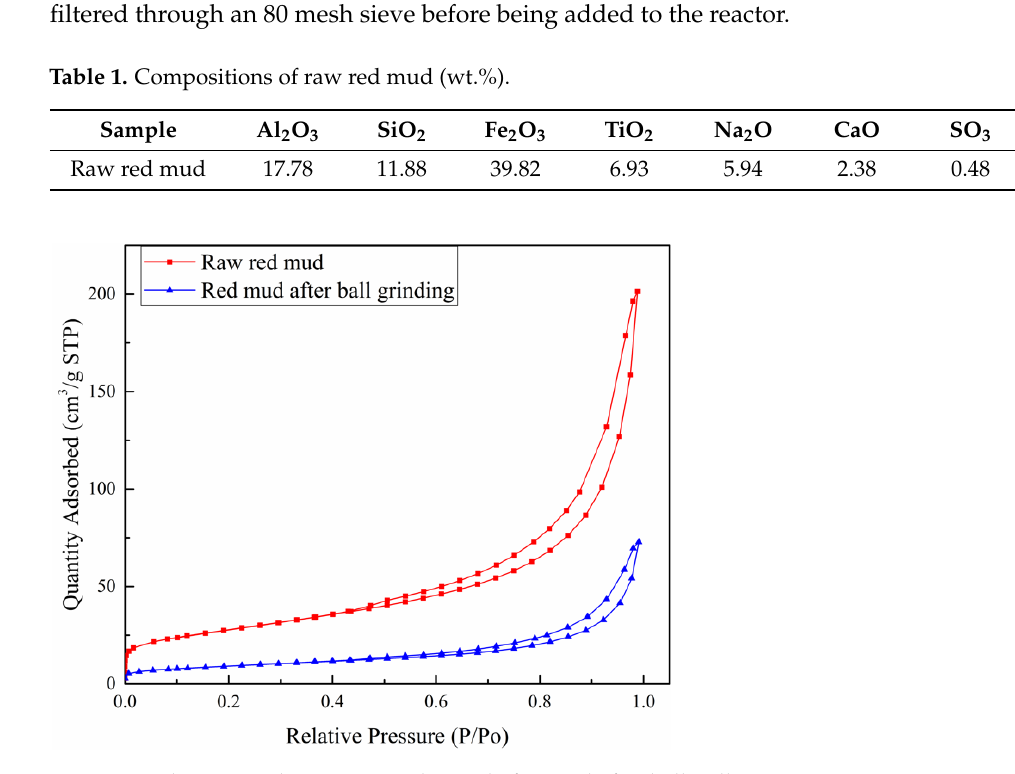
Figure 3. Adsorption–desorption isotherms before and after ball